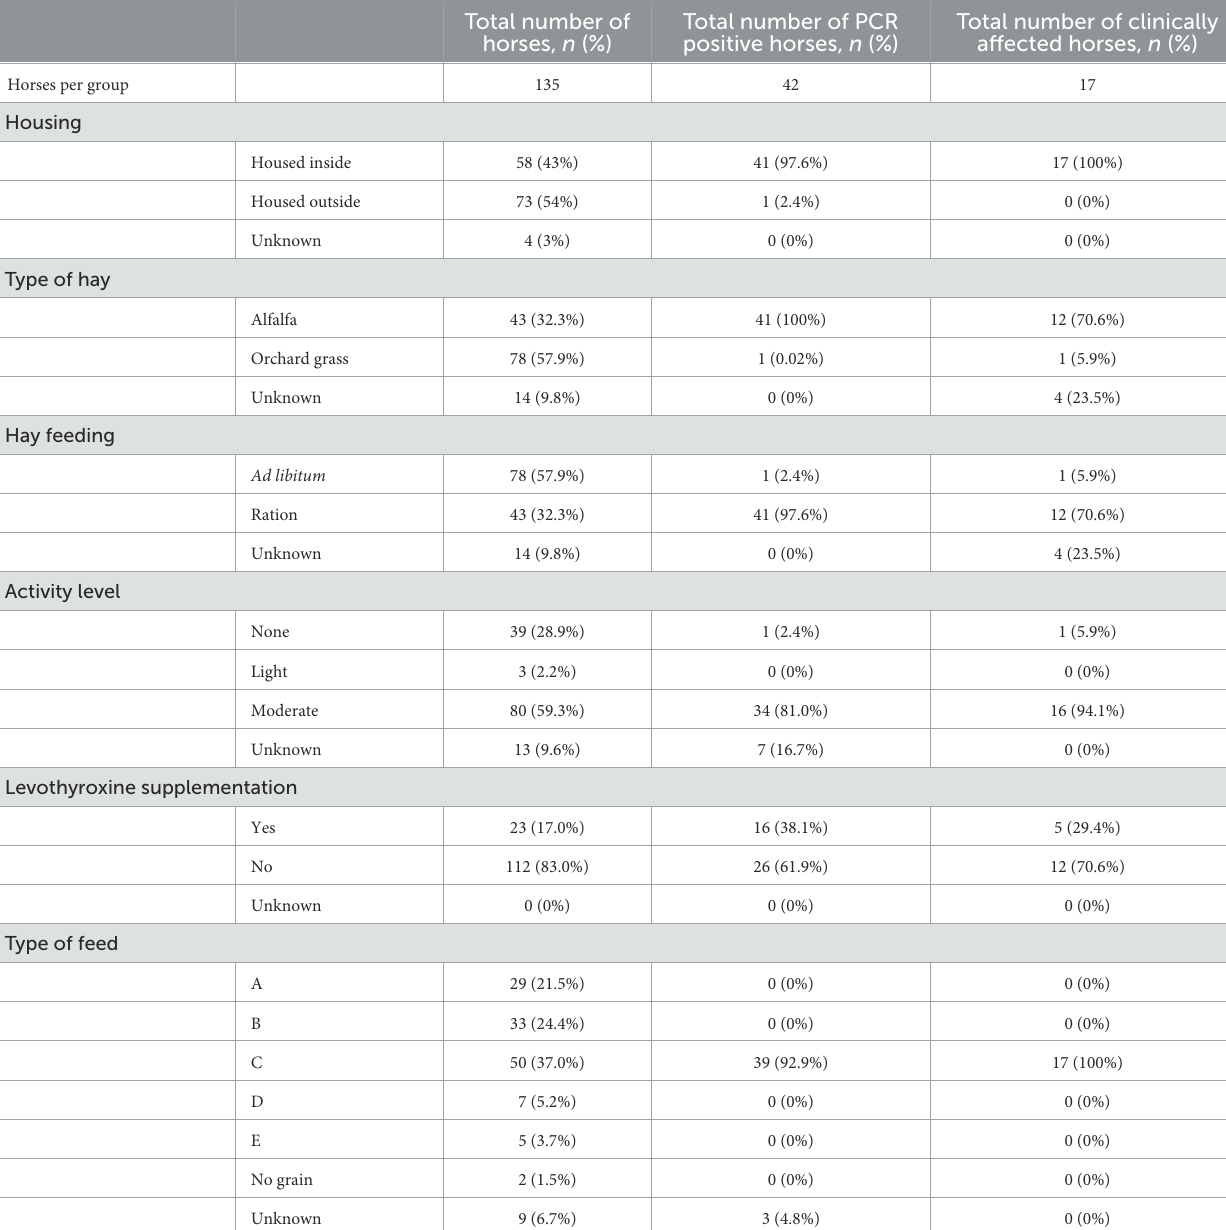
Total number of Total number of PCR Total number of clinically horses, n (%) positive horses, n (%) affected horses, n (%)